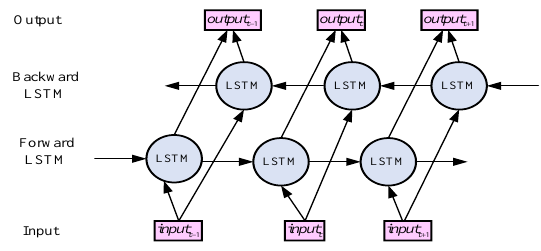
Figure 7. BiLSTM network structure.